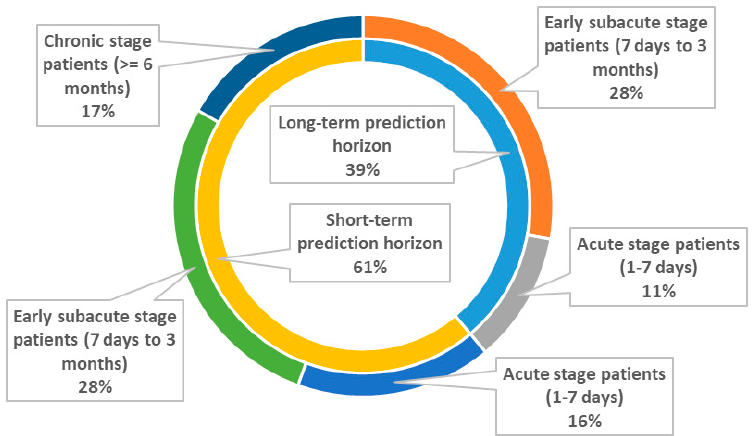
Figure 2. Employed studies in motor function category according to prediction horizon.